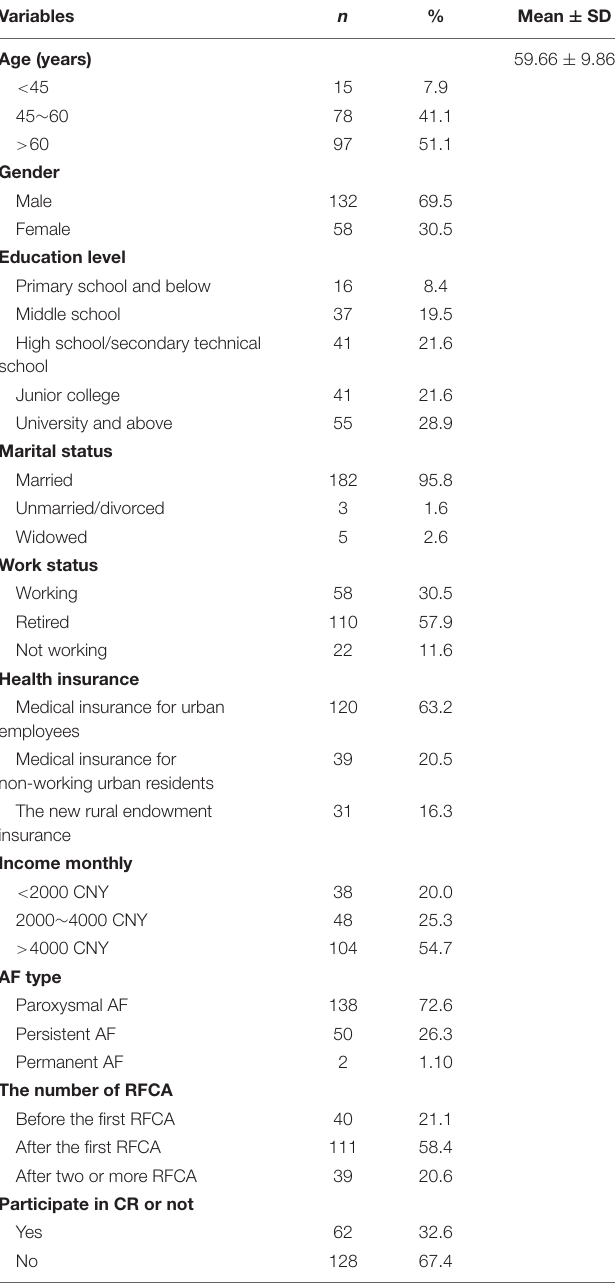
TABLE 1 | General characteristics ( n =